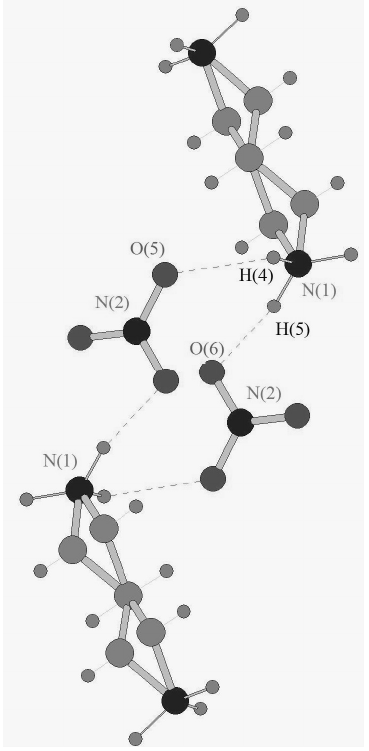
O) [C H N ] (NO ) . 2 6 3 12 2 3 4 O) [C H N ] (NO ) is shown in Figure 5. To 2 6 3 12 2 3 4